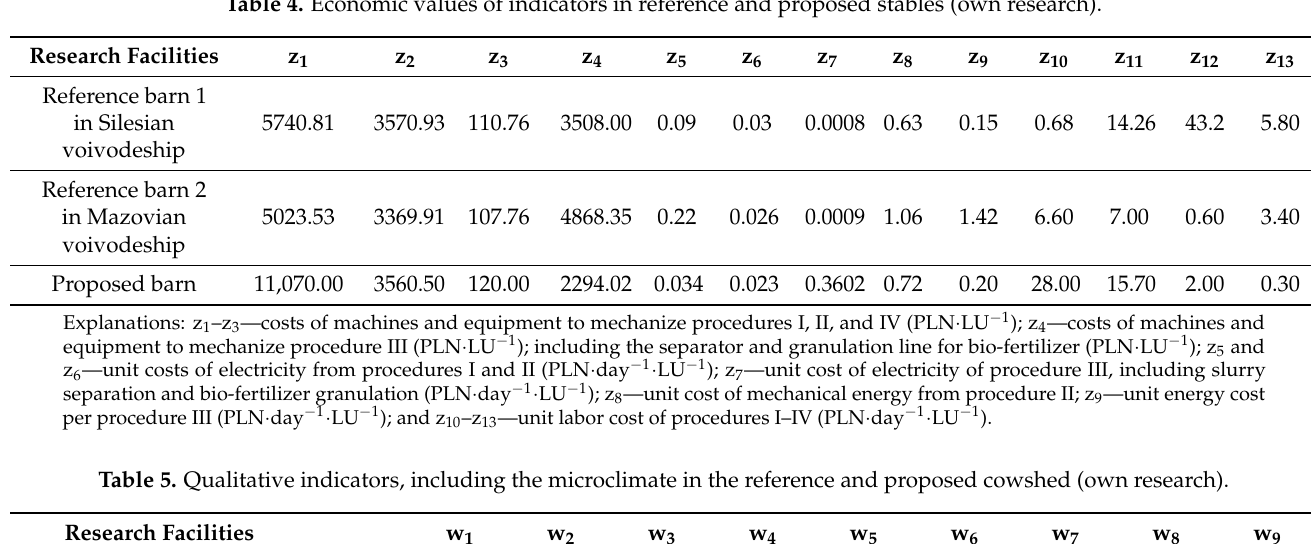
Table 4. Economic values of indicators in reference and proposed stables (own research).